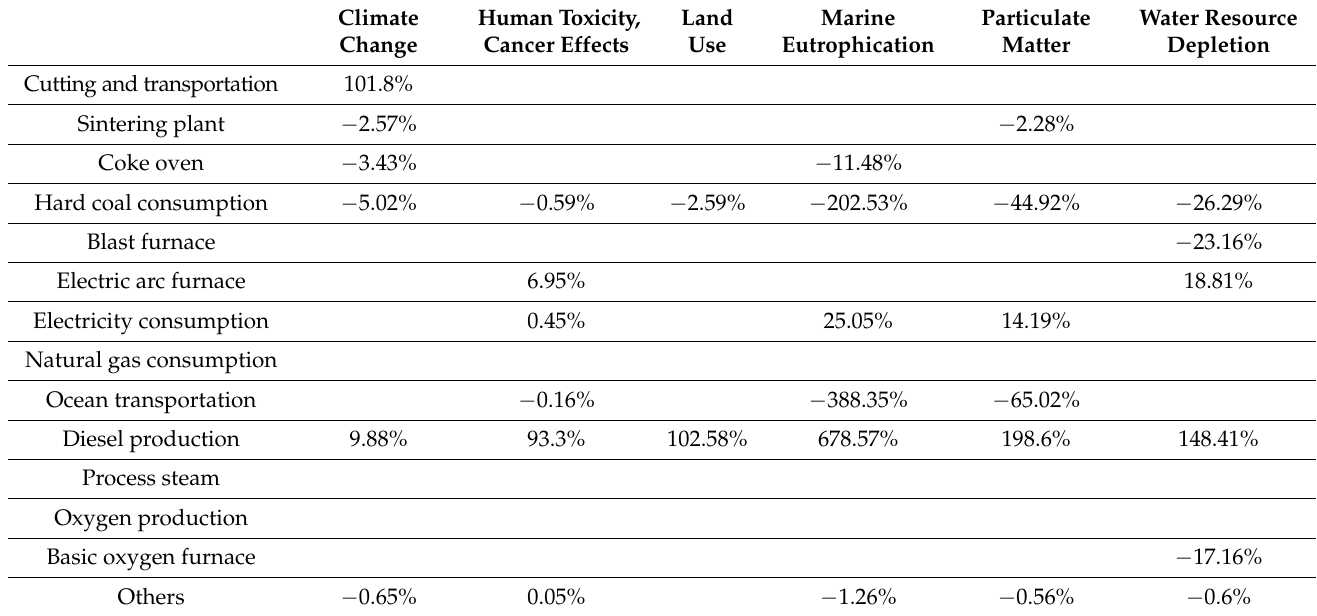
Figure 4. Barplot of unit process contributes to total impact categories values. Table 3 shows the results of the analysis in percentage terms for all process units. Table 3. Contribution analysis per unit process.